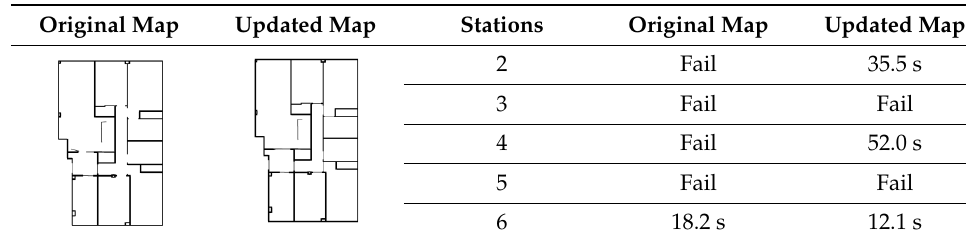
19 of 23 Figure 13. Evolution of particle swarms for actual door configuration OOOOXO using an accurate map (OOOOXO) and inaccurate map (OOOOOO). All adjacent doors were closed for the remainder of the kidnapped localization at